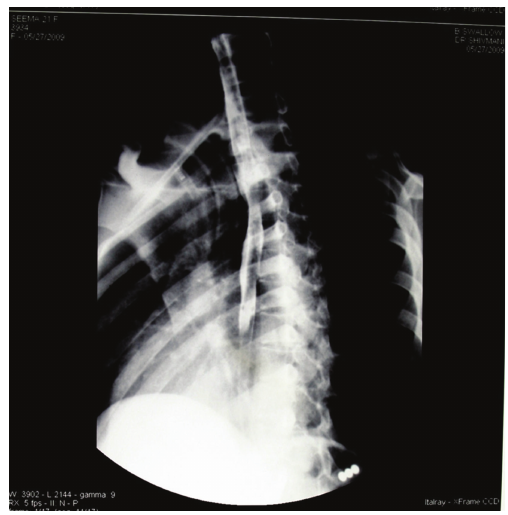
Figure 3: Barium swallow showing normal study.